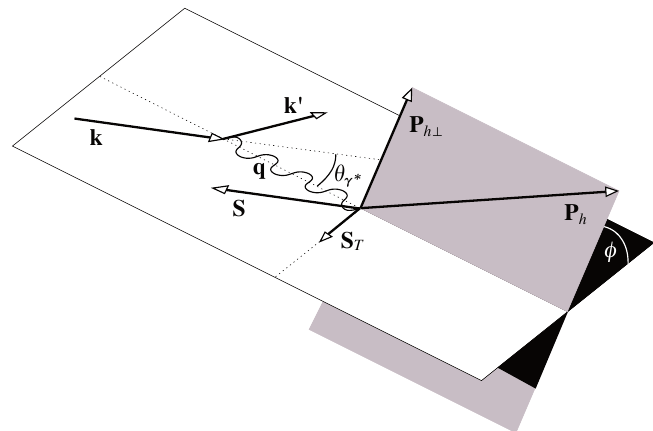
Figure 37 . Illustration of the mixing of longitudinal and transverse target polarizations w.r.t. the virtual-photon direction when polarizing the target along the lepton-beam direction. In this par- ticular case of longitudinal target polarization, a small component transverse to the virtual-photon direction arises that is proportional to sin θ γ ∗